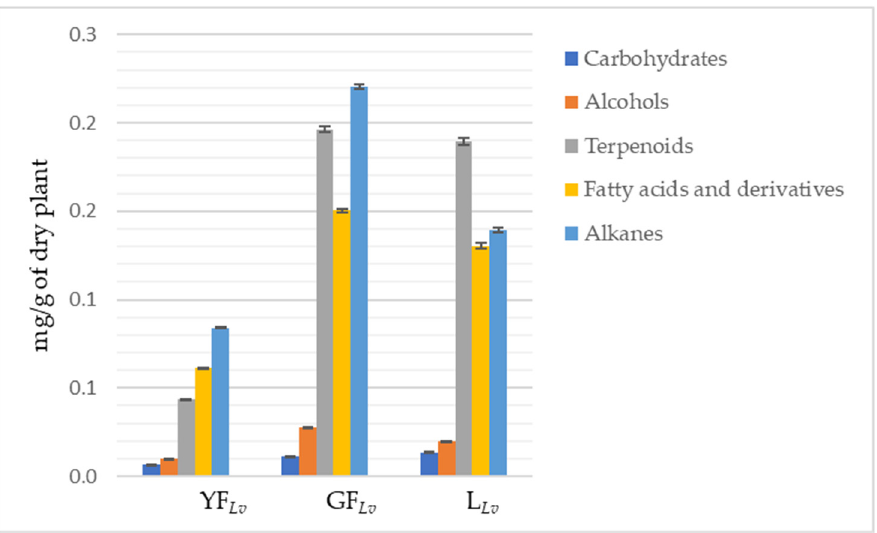
Figure 2. Graphical representation of the total amount of each class of specialized metabolites for the studied plant parts. All classes are statistically different (Tukey’s test; p <